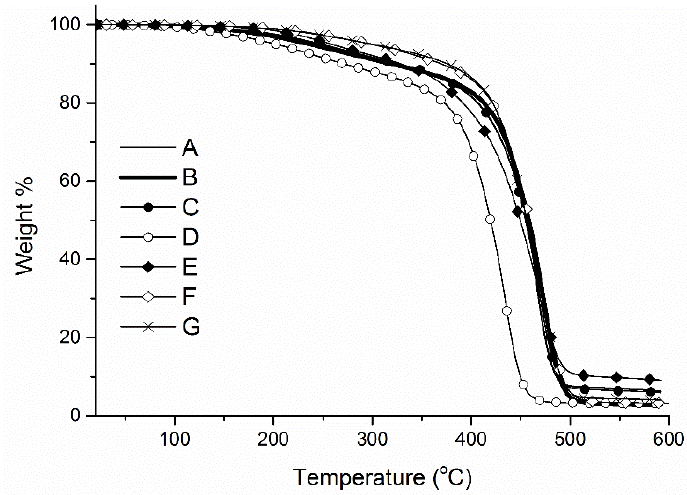
Figure 9. Thermogravimetric analysis (TGA) curves of tung oil-based resins, cured in a convection oven for 6 h at 140 °C, reinforced with (A) 0.00 wt % CNTs; and (B) 0.25 wt % CNTs, and tung oil-based resins, cured under microwaves at 100 W for 10 min, followed by 200 W for 10 min, and a 2 h 10 min post-cure step at 140 °C, in a convection oven,